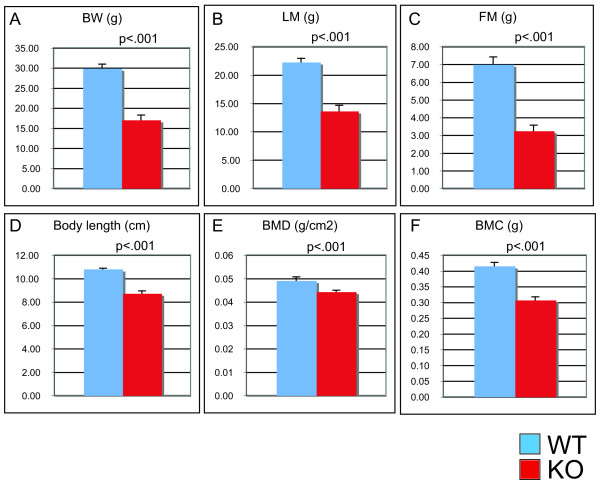
VGF-deficient mice on a C57Bl6 background have decreased fat and lean body mass, and decreased bone mineral density and content. Body weight (Panel A) (grams), body composition (Panels B and C) [lean mass (LM) and fat mass (FM)] (grams), length (Panel D) (cm), bone mineral density (BMD) (Panel E) (g/cm2) and bone mineral content (BMC) (Panel F) (grams), were determined in VGFR mice using dual emission x-ray absorption. Data are expressed as mean ± SEM (n = 7-8 male mice of each genotype per group).